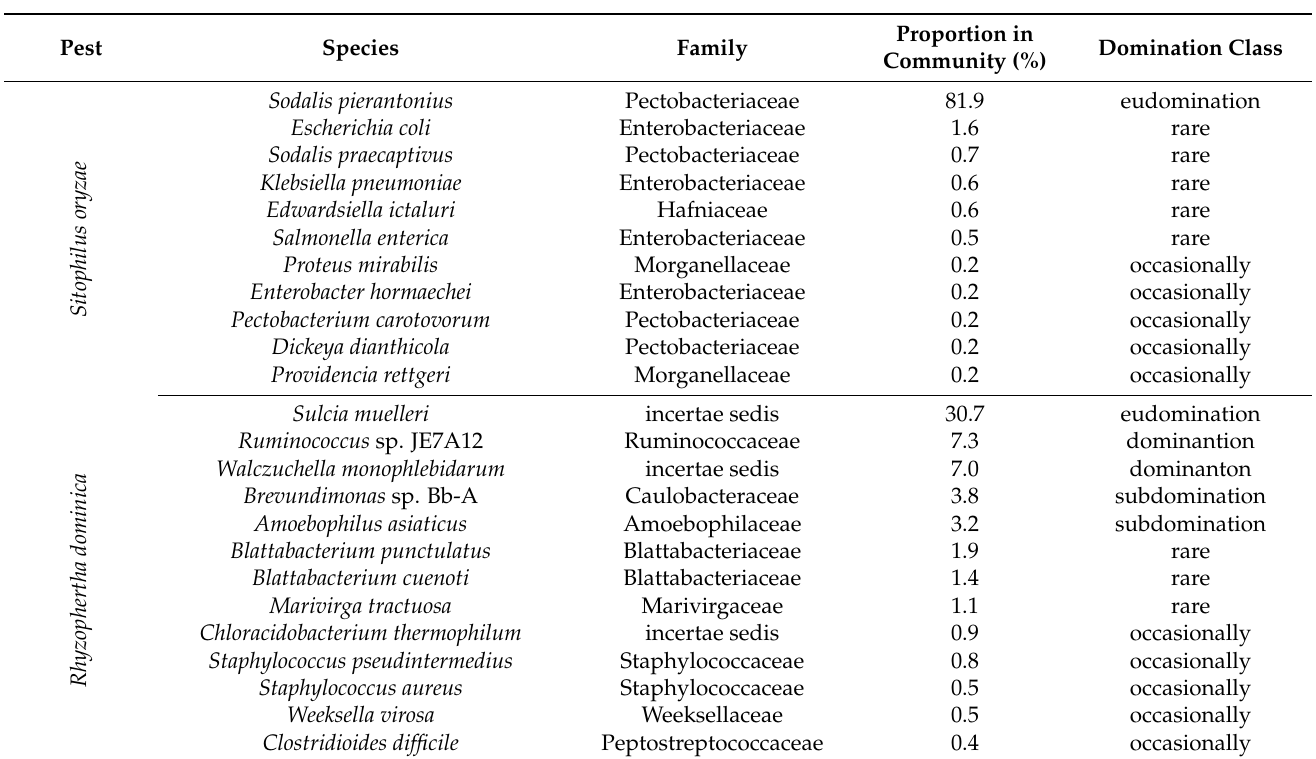
Table 1. Taxonomic characteristics of the bacterial microbiome inhabiting the digestive system of S. oryzae and R. dominica